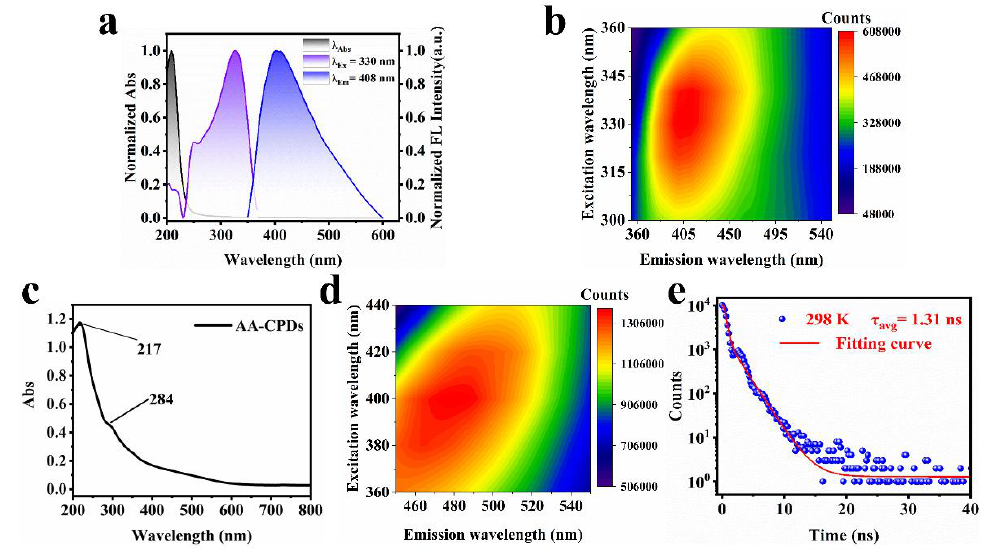
Figure 4. ( a ) The normalized UV – vis absorbance, FL excitation and emission spectra of AA-CPDs in water. ( b ) Fluorescence spectra of AA-CPDs in water. ( c ) UV – vis spectrum of the solid AA-CPDs. ( d ) Fluorescence spectra of the solid AA-CPDs. ( e ) FL decay curve of the AA-CPDs in water.